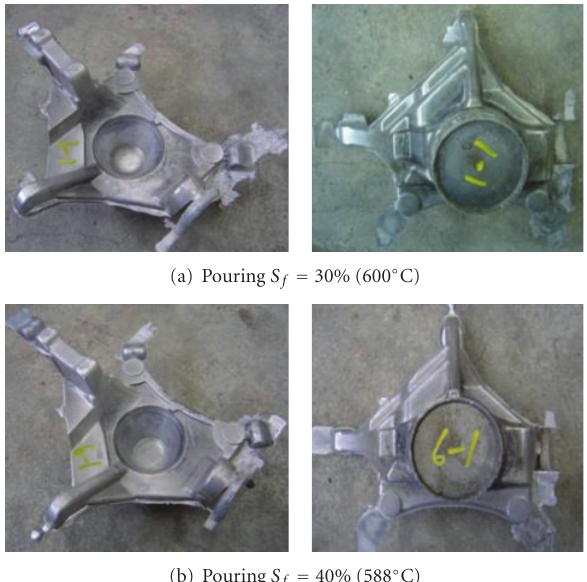
Figure 30: Result of indirect rheo-forging test of rheological materials.